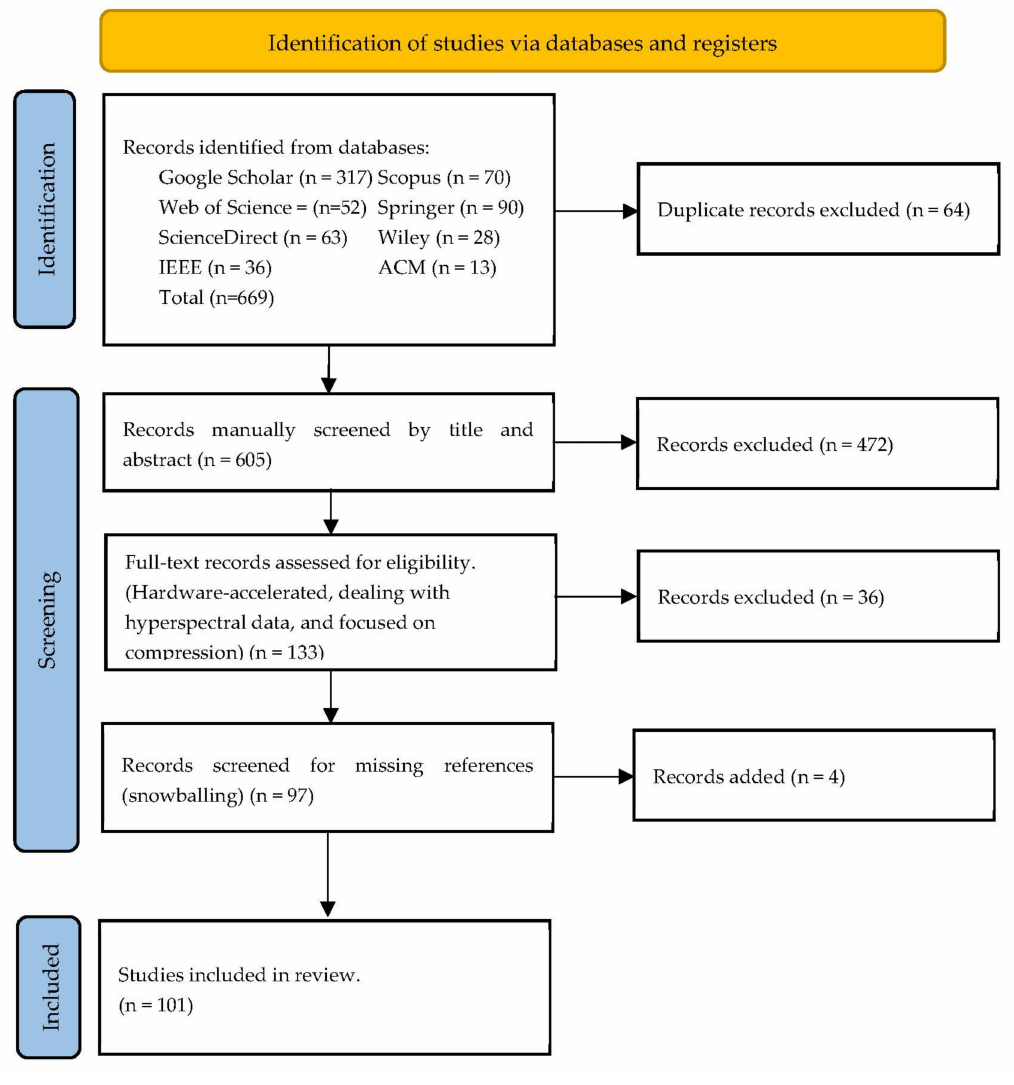
Figure 3. The records selection process using the PRISMA framework as applied in this